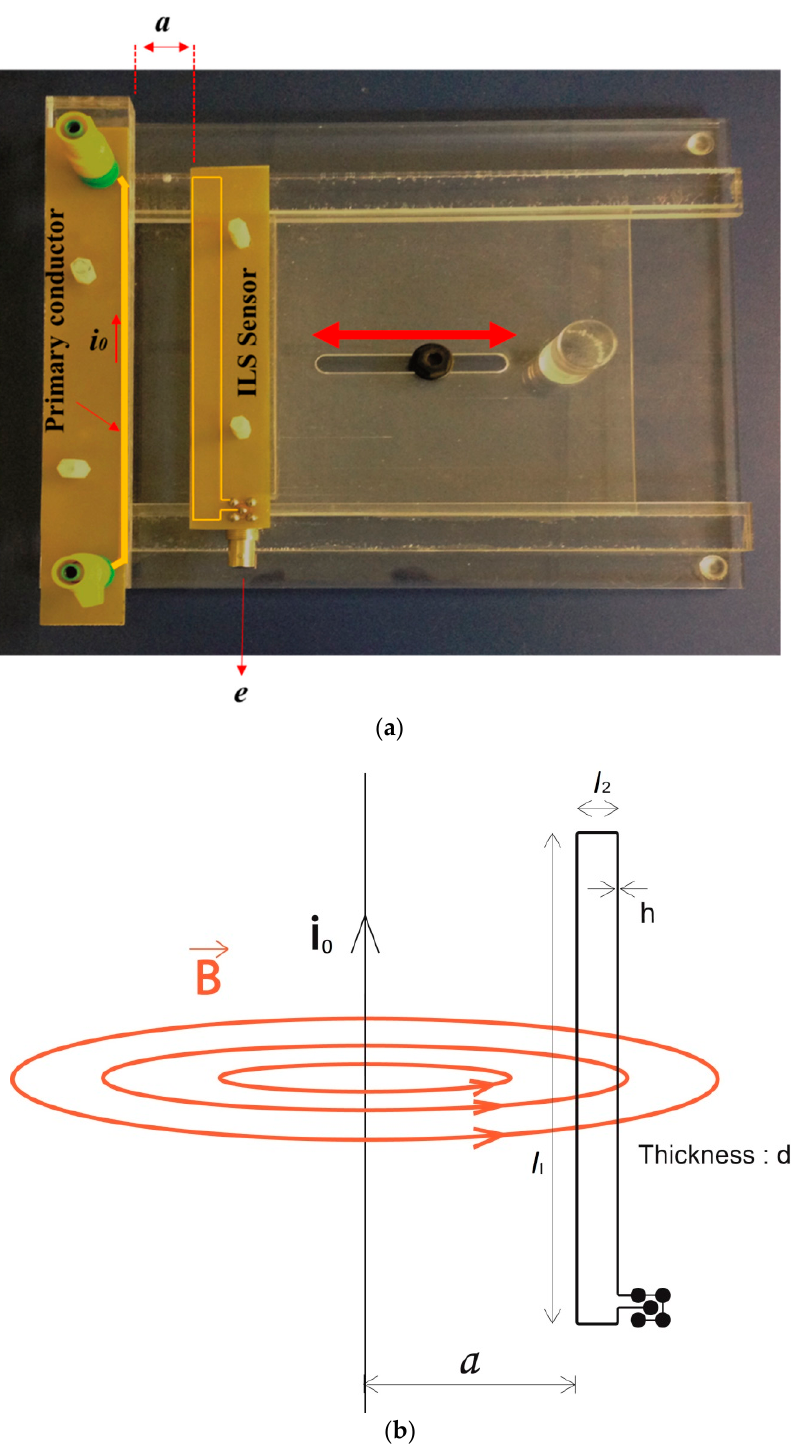
Figure 1. ( a ) Adjustable experimental measurement prototype; ( b ) scheme of the ILS used.